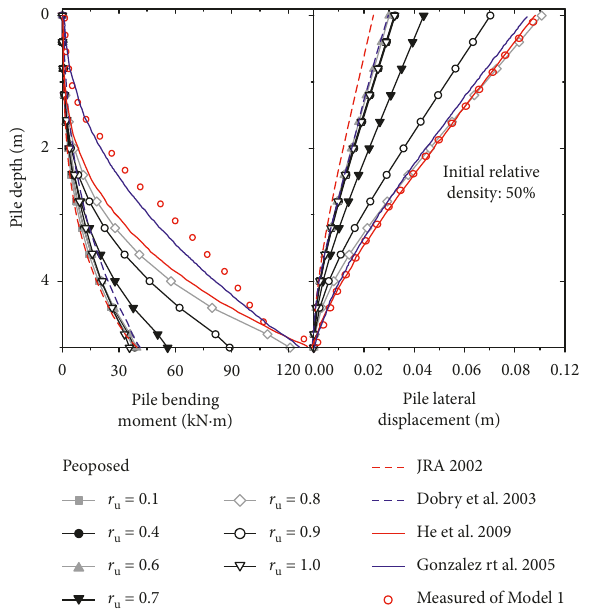
Figure 6: Comparison of pile response obtained using different